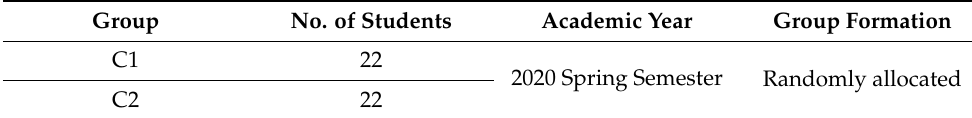
Table 1. Characteristics of participant student groups.